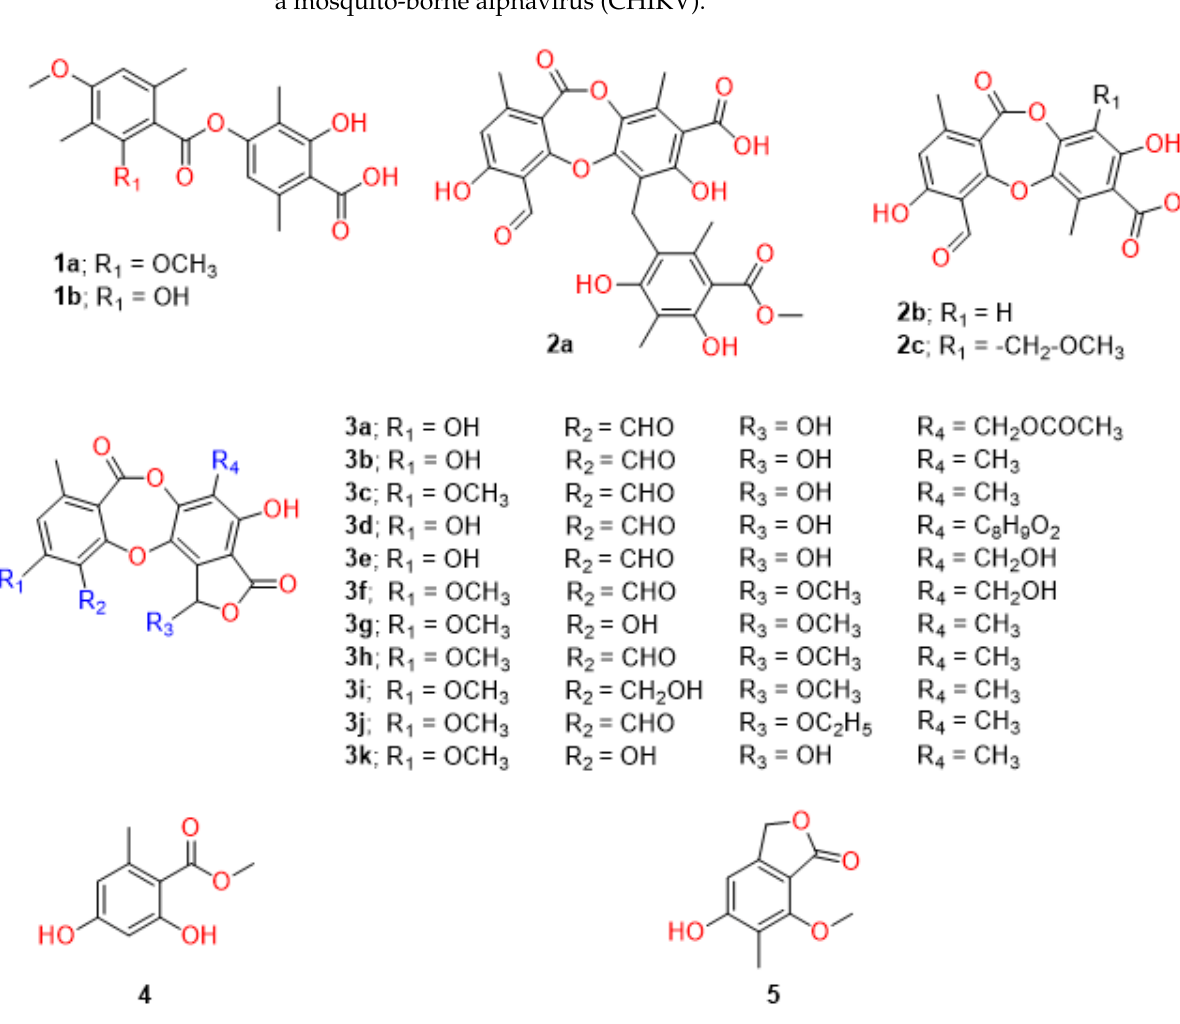
Figure 1. Chemical structures of depsides, depsidones, and their substructures.